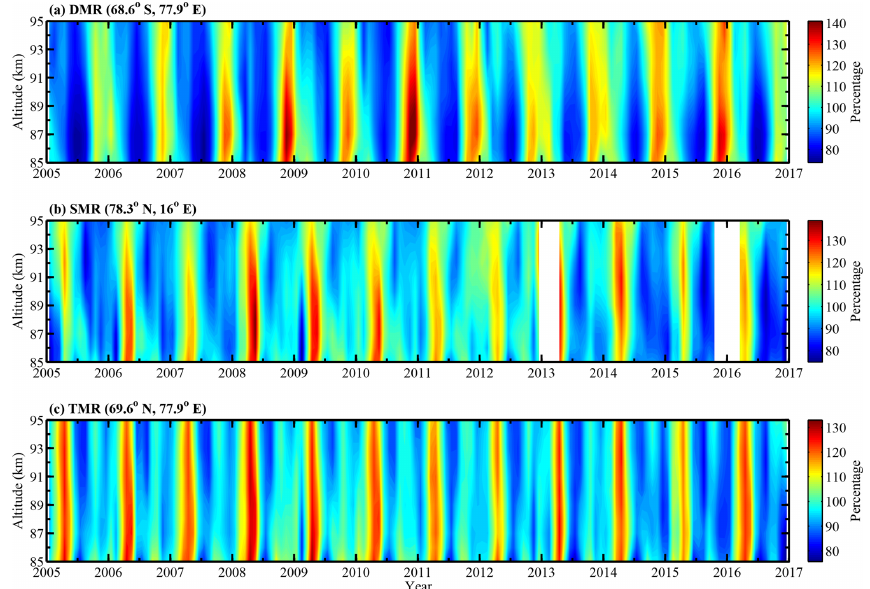
Figure 3. Variations in the monthly mean relative densities at altitudes from 85 to 95km obtained from the DMR, SMR and TMR between 2005 and 2016. The color bars indicate the percentage variation in the monthly mean density relative to the mean density from the total observational time period.